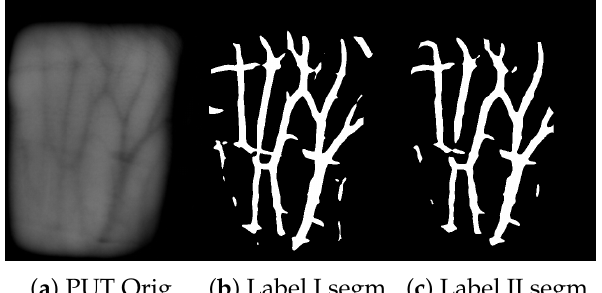
Figure 27. Segmentation of the ensemble on the PUT